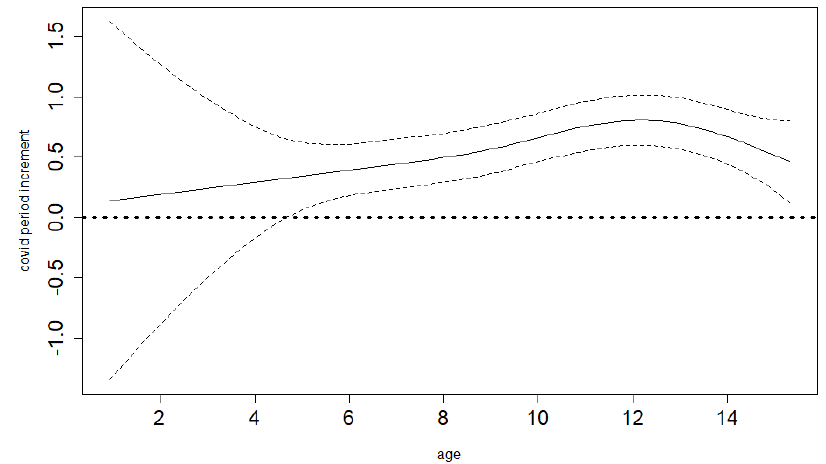
Figure 4. Baseline BMI age profile for girls, estimated smooth trend (solid line) and pointwise 95% confidence interval limits (dotted lines). Age in years.